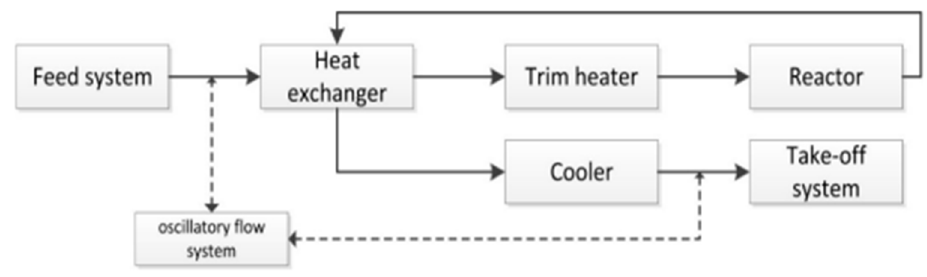
Figure 4. Schematic of the HTL system developed by Johannsen et al. [78].